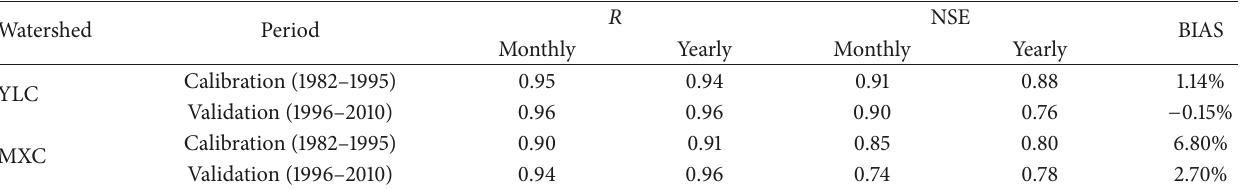
Table 2: Performance assessments of the SWAT model in the two watersheds.